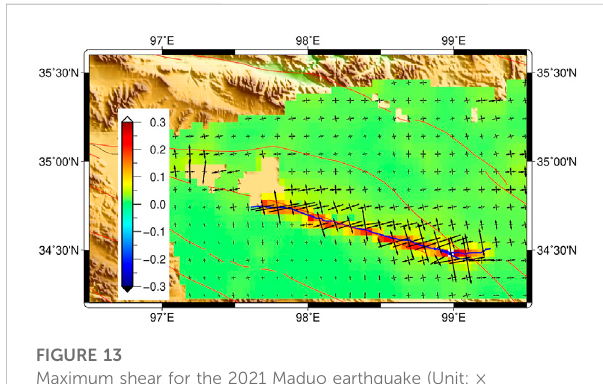
FIGURE 13 Maximum shear for the 2021 Maduo earthquake (Unit: × 10 − 4